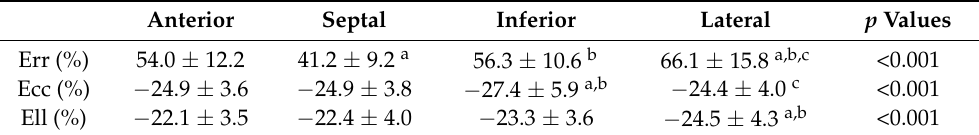
Anterior Septal Inferior Lateral p Values